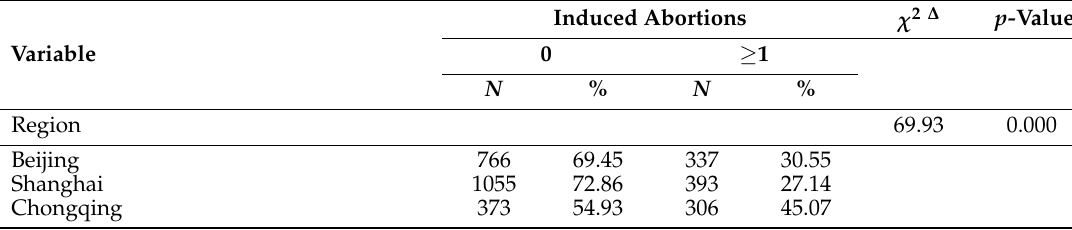
Table 2. Distribution of induced abortions in different contextual and reproductive factors ( N = 3230). Induced Abortions χ 2 ∆ p- Value 0 ≥ 1 Variable N % N % Region 69.93 0.000 Beijing 766